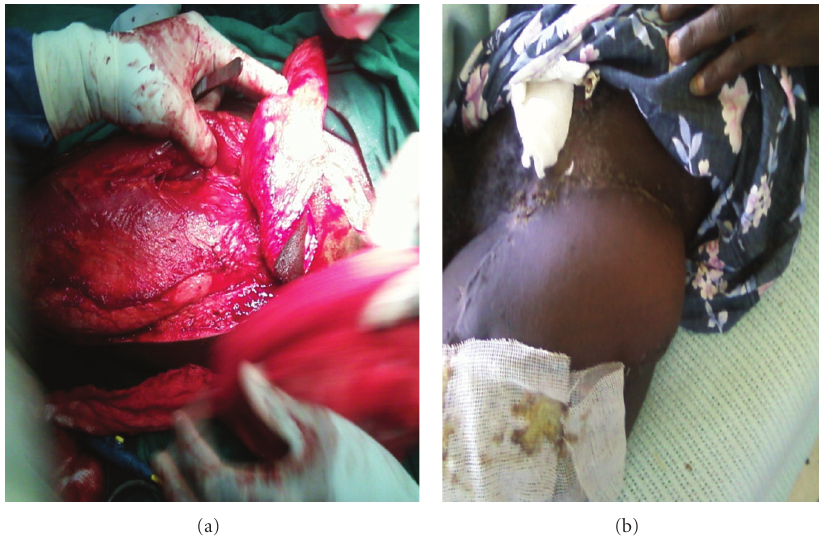
Figure 3: The pedicle and healing flap and